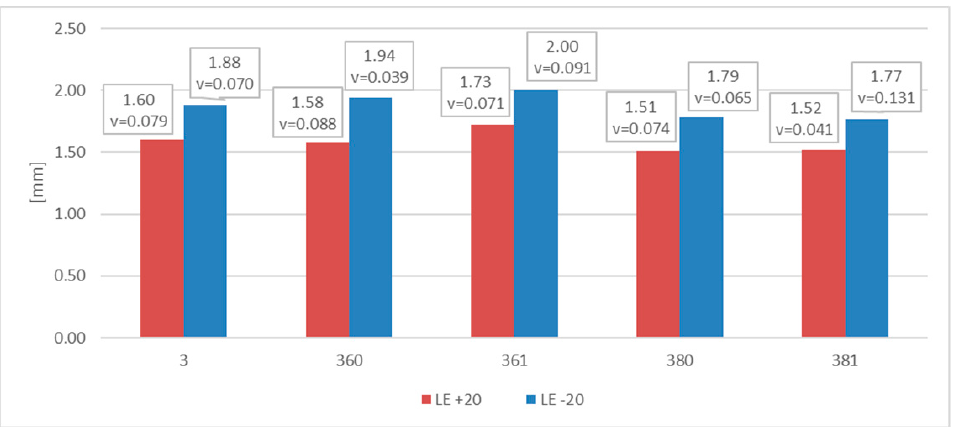
Figure 20. Averaged values of the LE parameter and corresponding coefficients of variation (estimated on a statistical sample) obtained on impact toughness test samples made of X6CrNiTi18-10 steel.